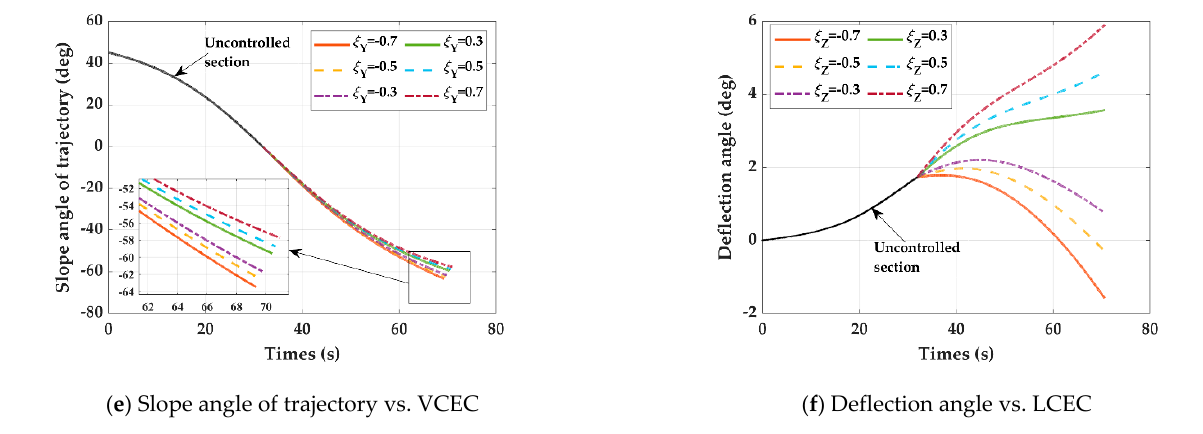
Figure 3. Trajectory parameter profiles with different CECs. 1) Table 2. Projectile parameters and initial